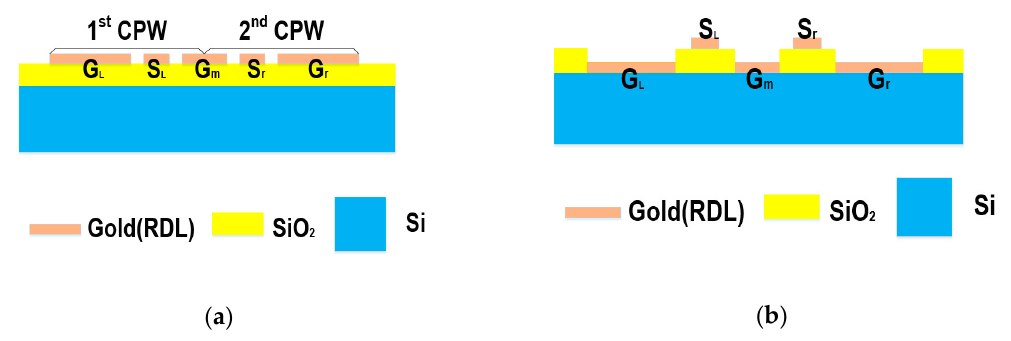
Figure 2. The RDL structure: ( a ) The conventional CPW RDL structure; ( b ) Ohm contact CPW RDL structure. Adapted with permission from [44], Copyright IEEE, 2016.